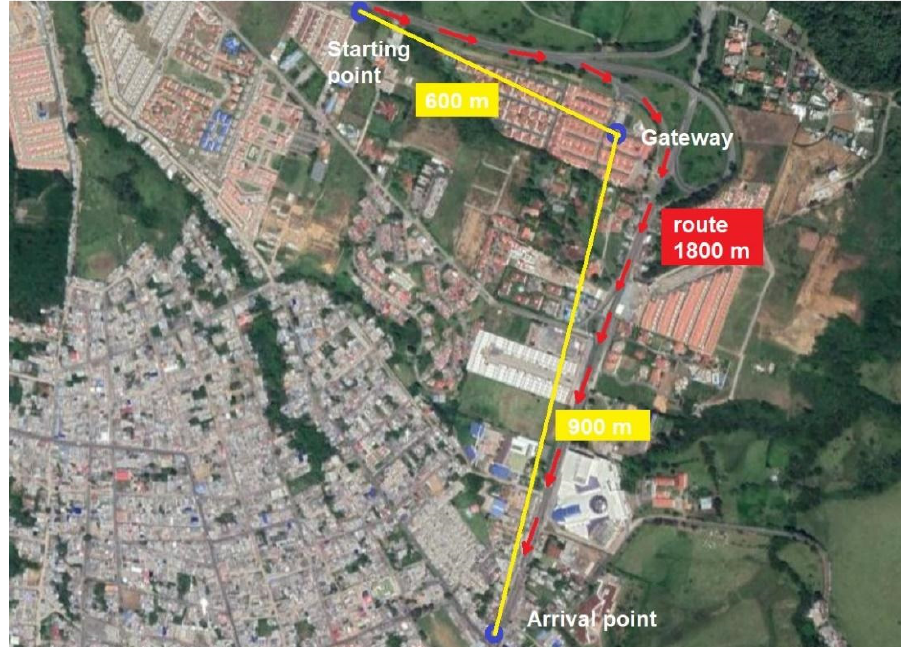
Figure 6. Vehicle route in Experiment 6 and distances to the gateway.